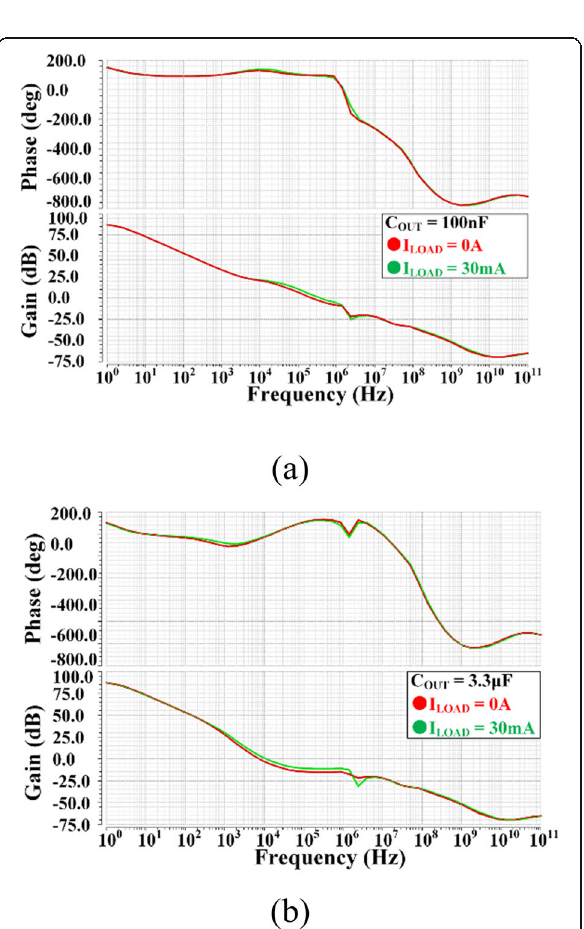
Fig. 10 Loop frequency responses of proposed VR under different value of I Load and C OUT conditions. a C OUT = 100 nF, b C OUT = 3.3 F. Red and green line represents I Load of 0 A and 30 mA,